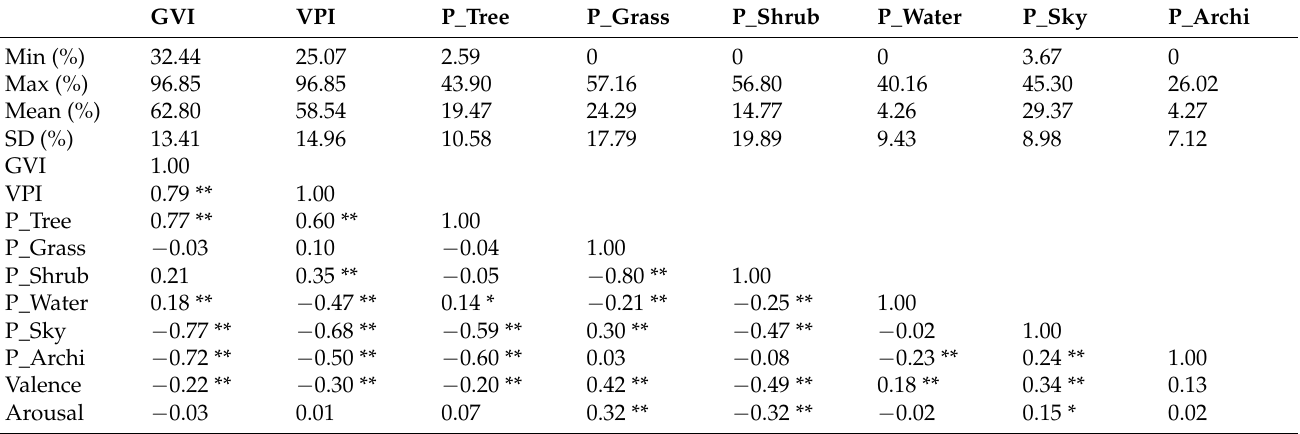
Table 4. Statistical information of variables for all primary stimulation and two-tailed Pearson’s r correlations between variables and emotional